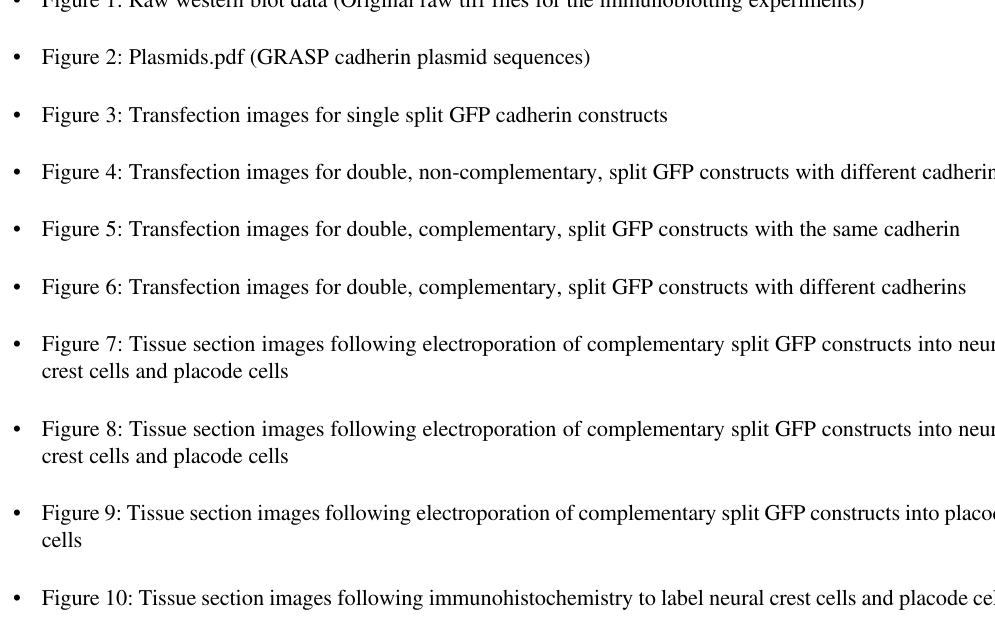
(cid:129) Figure 1: Raw western blot data (Original raw tiff files for the immunoblotting experiments) (cid:129) Figure 2: Plasmids.pdf (GRASP cadherin plasmid sequences) (cid:129) Figure 3: Transfection images for single split GFP cadherin constructs (cid:129) Figure 4: Transfection images for double, non-complementary, split GFP constructs with different cadherins (cid:129) Figure 5: Transfection images for double, complementary, split GFP constructs with the same cadherin (cid:129) Figure 6: Transfection images for double, complementary, split GFP constructs with different cadherins (cid:129) Figure 7: Tissue section images following electroporation of complementary split GFP constructs into neural crest cells and placode cells (cid:129) Figure 8: Tissue section images following electroporation of complementary split GFP constructs into neural crest cells and placode cells (cid:129) Figure 9: Tissue section images following electroporation of complementary split GFP constructs into placode cells (cid:129) Figure 10: Tissue section images following immunohistochemistry to label neural crest cells and placode